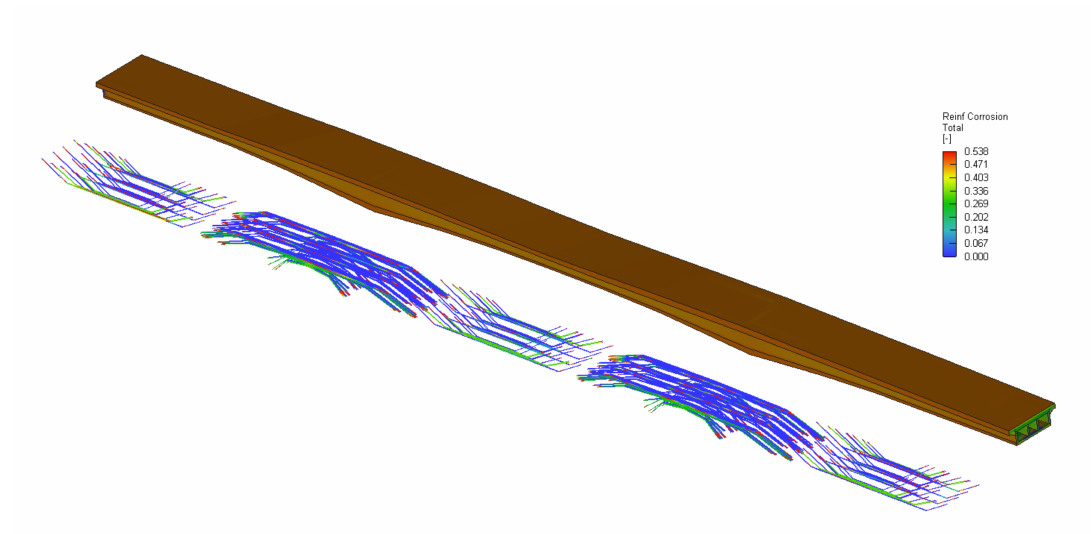
Figure 4. (top) Plot of the reinforcement corrosion of the smeared reinforcement in the shell elements and (bottom) corrosion of the pre-stressed cables in the webs of the girder box after 100 years of chloride ingress.